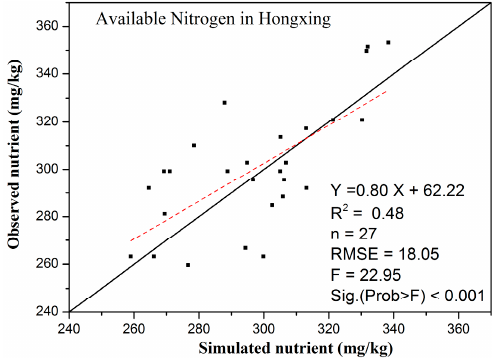
Figure 8. Analysis results of available nitrogen simulation.